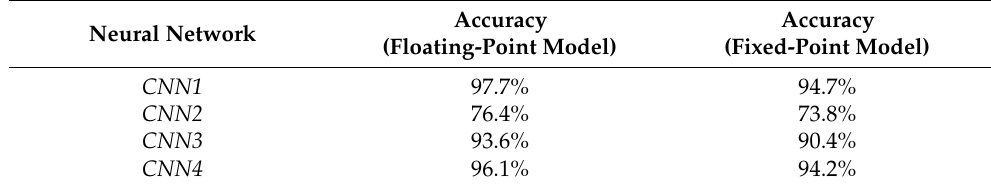
Table 8. Effect of